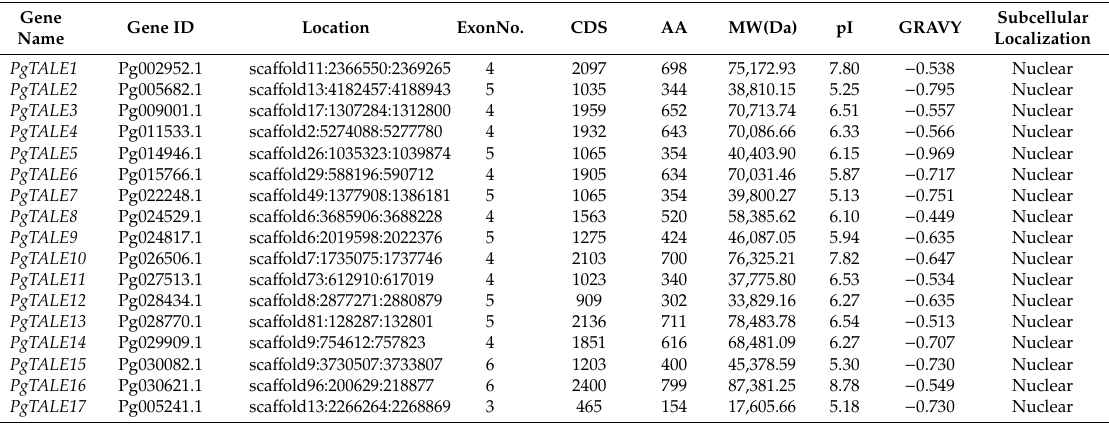
Table 2. The basic information of the TALE gene family in